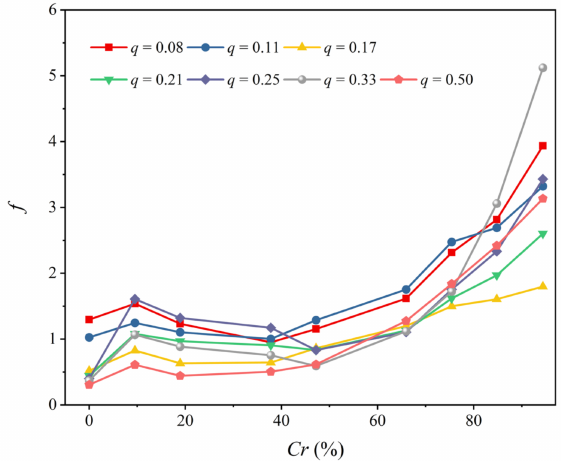
Figure 6. Relationship between resistance coefficient ( f ) and degree of coverage ( Cr